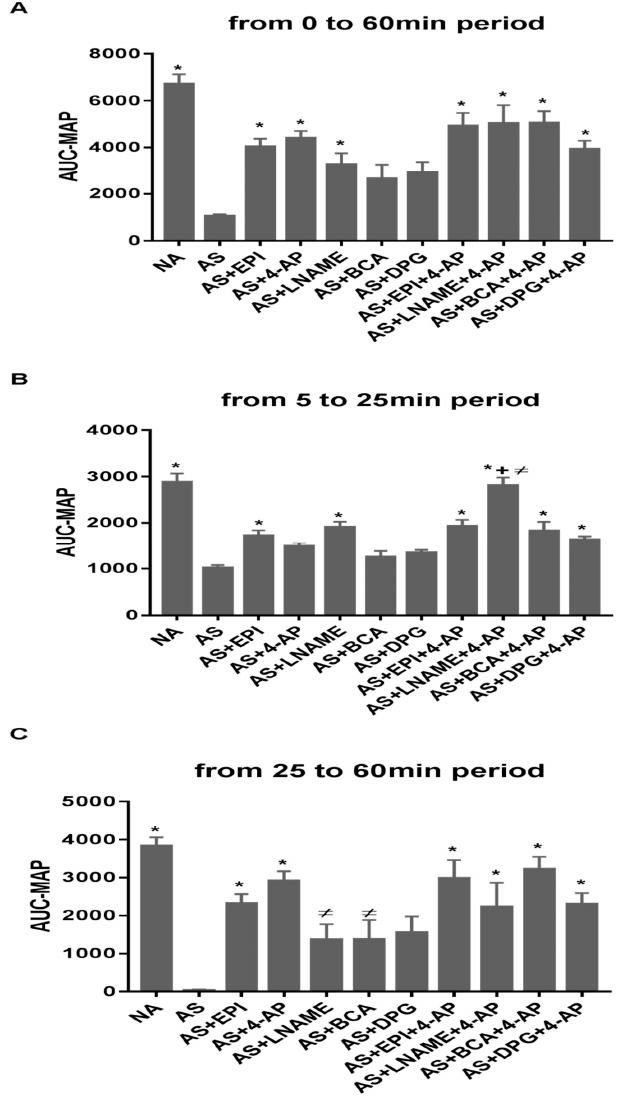
Figure 2. Integrated mean arterial blood pressure (area under the curve, AUC-MAP) during the full 60 min experiment ( A ), during the early experimental period from 5 to 25 min, ( B ) or during the late experimental period from 25 to 60 min ( C ). * p < 0.05; significantly different vs. AS group; +, p < 0.05 vs. EPI group; ≠ , p < 0.05 vs. 4-AP group. Between 5 and 25 min, AUC-MAP (Figure 2B) was lower in AS than in NA groups ( p ˂ 0.0001). AUC-MAP was higher in EPI and L-NAME groups than controls ( p ˂ 0.009 and p ˂ 0.0006, respectively). BCA, DPG, and 4-AP treatments did not affect AUC-MAP. All 4- AP combination treatments showed higher AUC MAP values than for AS group ( p ˂ 0.0007 vs. AS+EPI+4-AP, p ˂ 0.0001 vs. AS+L-NAME+4-AP, p ˂ 0.001 vs. AS+BCA+4-AP, p ˂ 0.03 vs. AS+DPG+4-AP).